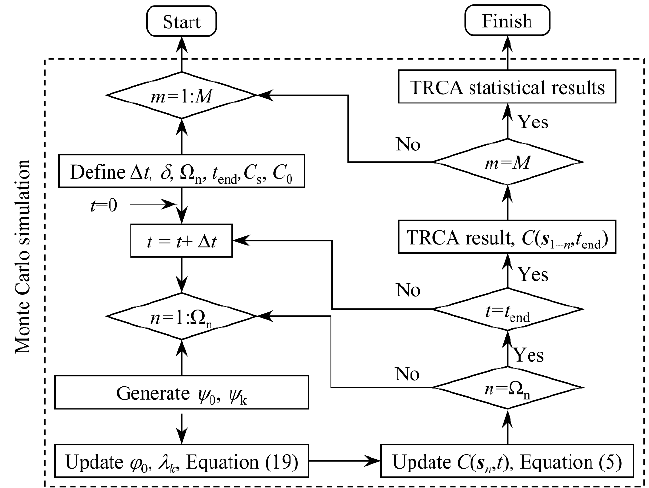
Figure 7. Calculation process and steps for the 3D RTCA model.